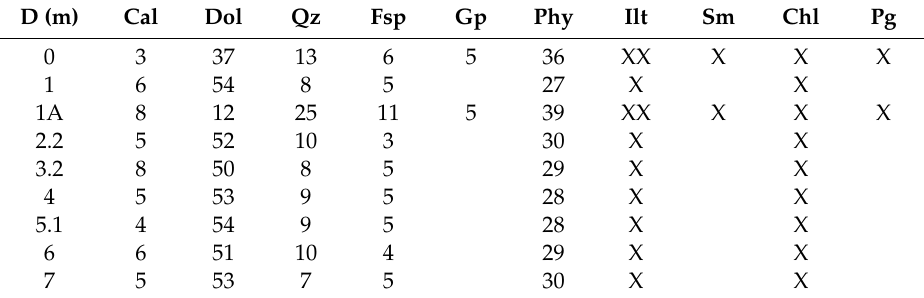
Table 2. XRD analysis of the samples from the central segment of the Baza Fault at the Carrizal site. The distance corresponds to the distance from fault, which is also shown on the x-axes of the plots in Figure 6.